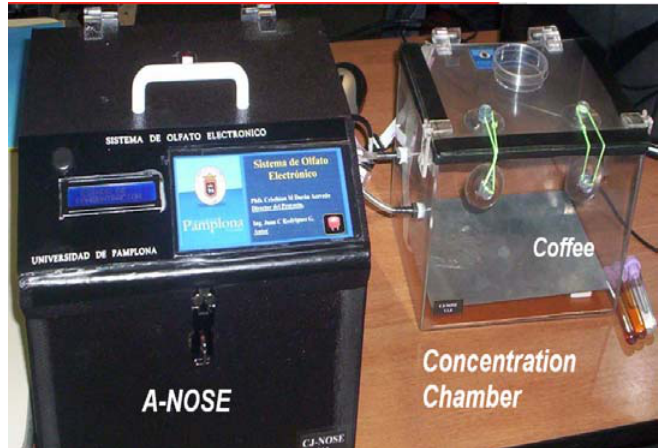
Figure 4. "A-NOSE" Electronic Nose